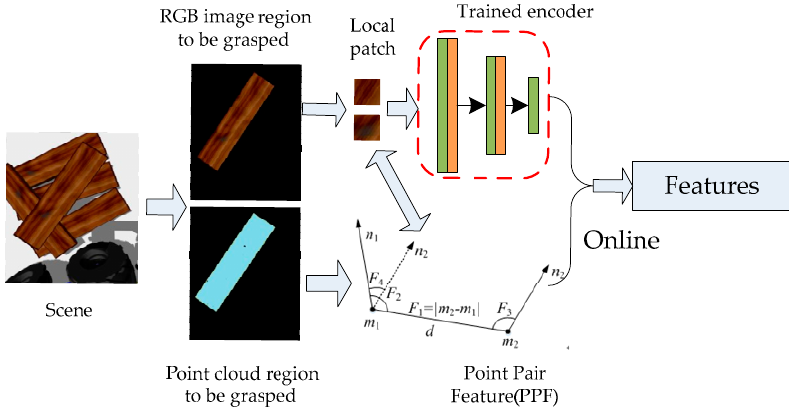
Figure 8. Generation of feature code of the wood plank to be grasped.